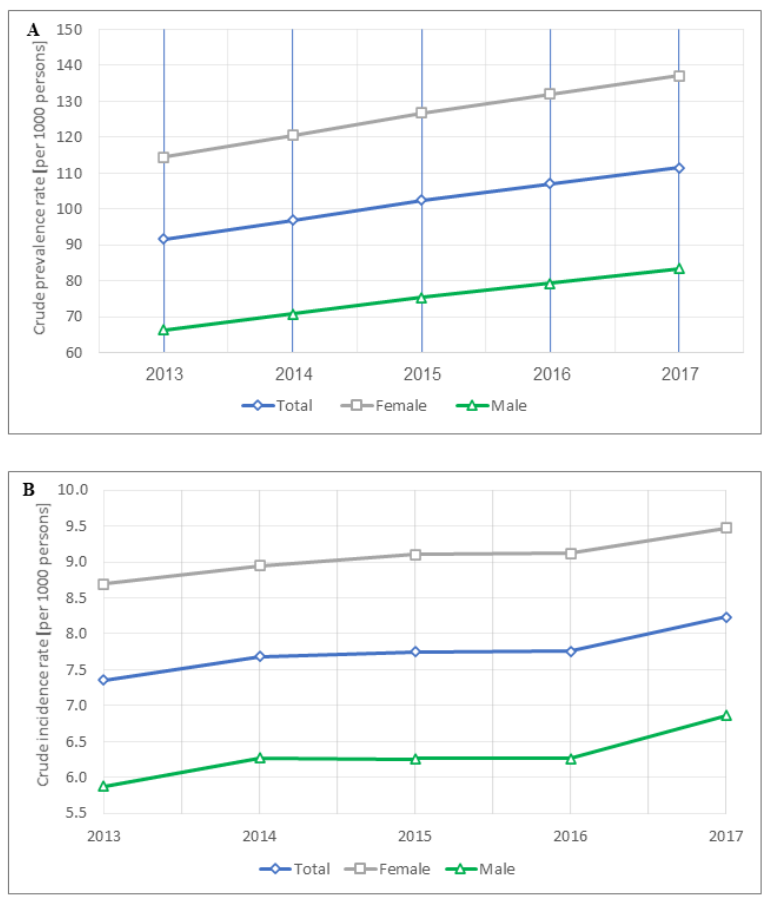
Figure 1. Trends for OA prevalence ( A ) and incidence ( B ) between 2013 and 2017, by sex. OA crude prevalence ratios and respective 95% CI in 2018, according to age, sex, and district, are shown in Figure 2. A significant positive relationship was observed between age and OA prevalence and followed a dose-response gradient pattern. The crude prevalence of OA in men was significantly lower than that in women (by 39%). OA prevalence varied from one region to another within Israel. The Southern and Northern peripheral districts had the highest OA prevalence of 146.5 per 1000 persons (95% CI, 145.0 – 148.1 per 1000 persons) and 123.2 per 1000 persons (95% CI, 121.9 – 124.5 per 1000 persons). The low- est prevalence proportions were observed in the Central and Sharon core districts (101.0